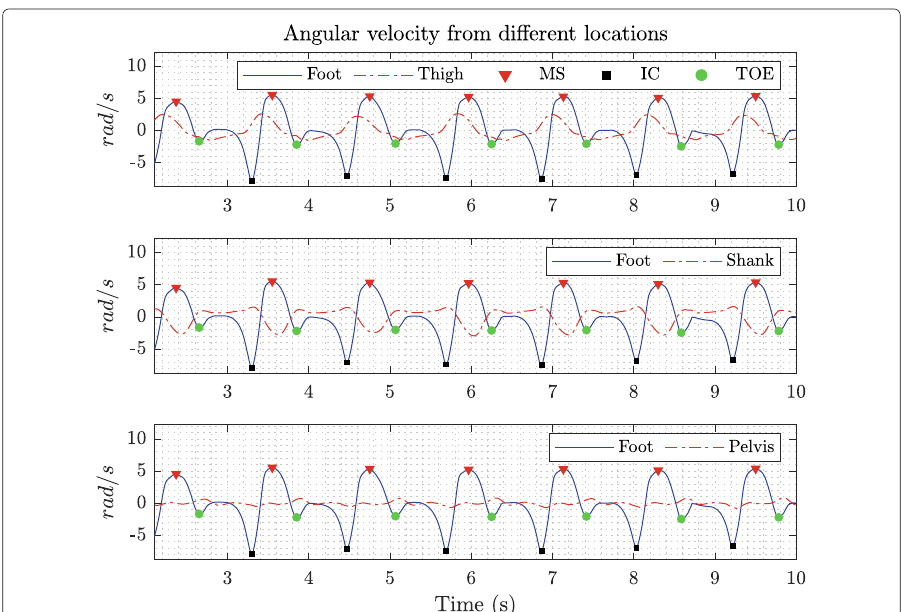
Fig. 4 Illustration of the angular velocity in the sagittal plane from different locations. The IC and TOE events are obtained from the foot angular velocity. The red triangle, green circle, and black square markers represent the mid-swing (MS), IC, and TOE,